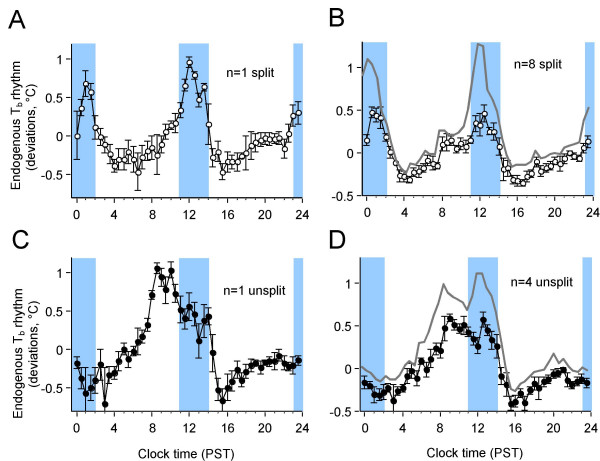
Estimates of the activity-independent Tb rhythms in individual (A, C) and groups (B, D) of split (A, B) and unsplit (C, D) hamsters maintained in LDLD9:3:9:3. Error bars for individual hamsters represent SEM of 6 values (days) at each time point. Error bars for groups represent between-subjects SEM. Estimates were derived by regressing Tb against GL and plotting residual values. In (B) and (D) the Tb rhythm (not removing influence of activity) is plotted (gray lines) in relation to the residual values.